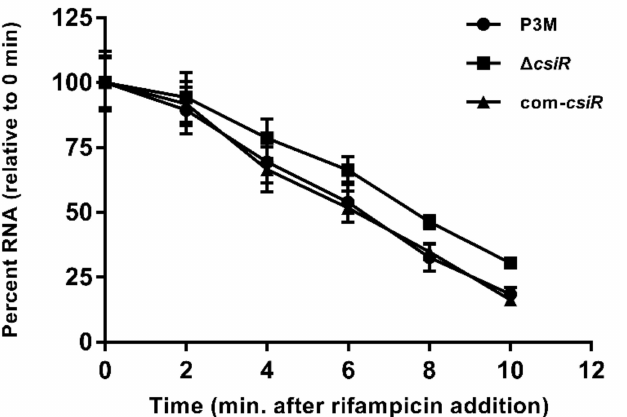
Figure 8. Determination of the half-life of emrB mRNA. Data were obtained from three independent repeated tests. Half-life data were obtained from three independent repeated tests ( n =